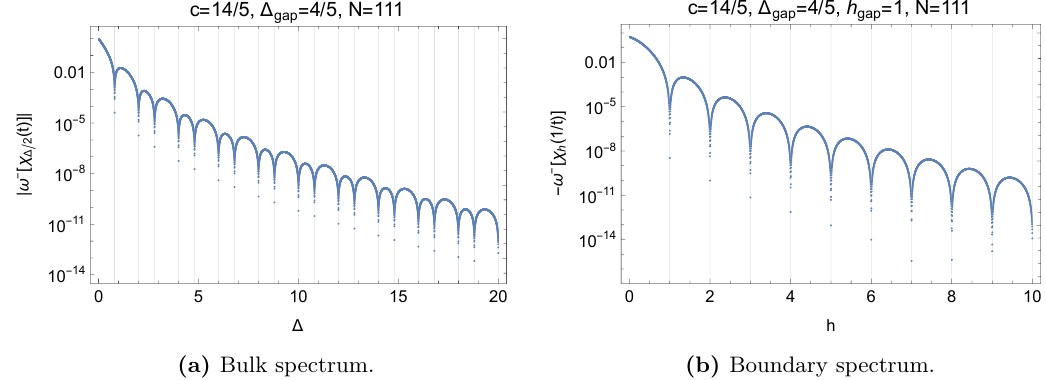
Figure 7. Action of the functional ω − that computes the lower bounds on g for the ( G 2 ) 1 WZW model on the bulk and boundary